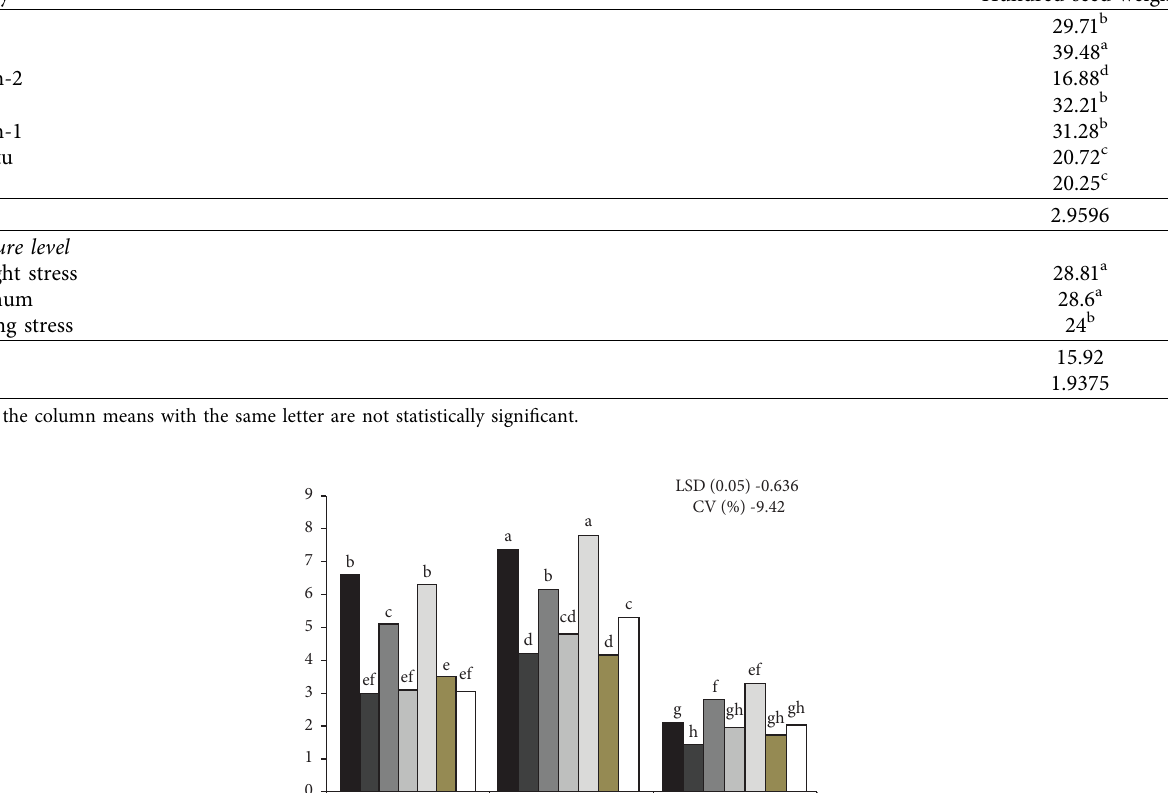
Table 10: Efects of common bean varieties and irrigation interval on hundred seed weight under lath house from June to September, 2020.